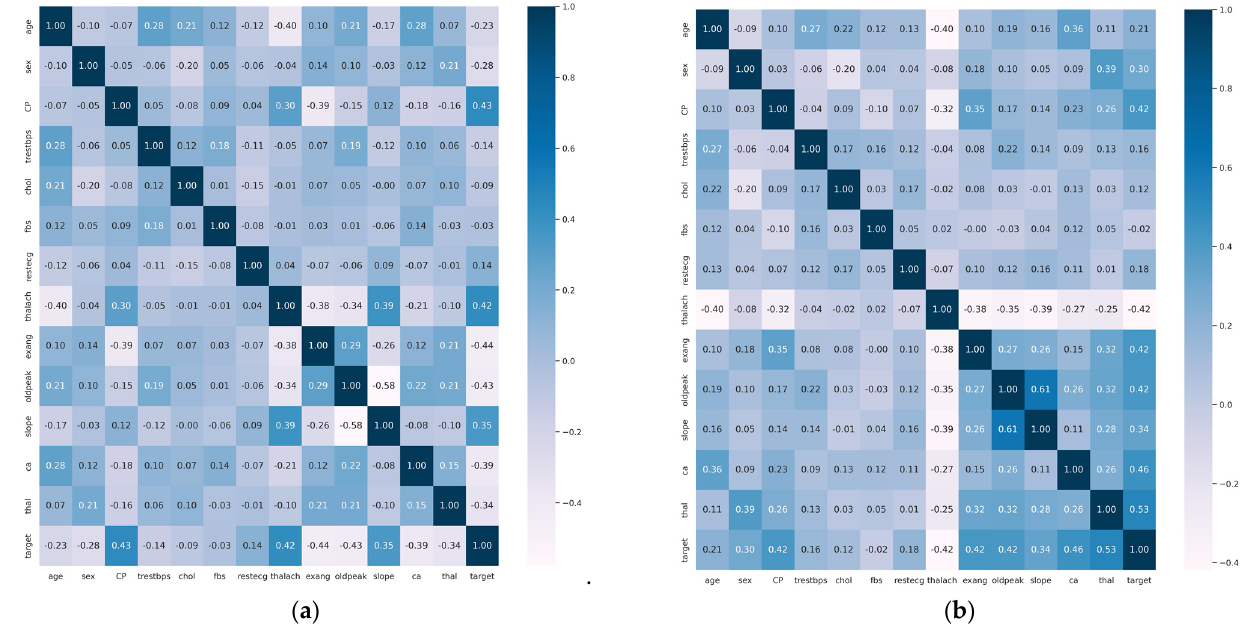
Figure 4. Correlation heat map. ( a ) Cleveland dataset; ( b ) Statlog dataset.